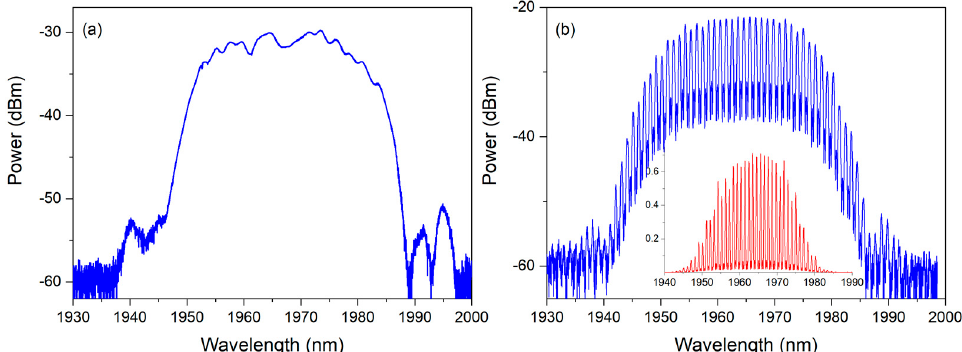
Figure 2. Optical spectra of dispersion-managed solitons: ( a ) stretched-pulse generation; ( b ) bound- state soliton generation mode; the inset presents the same optical spectrum in the linear scale (red trace).